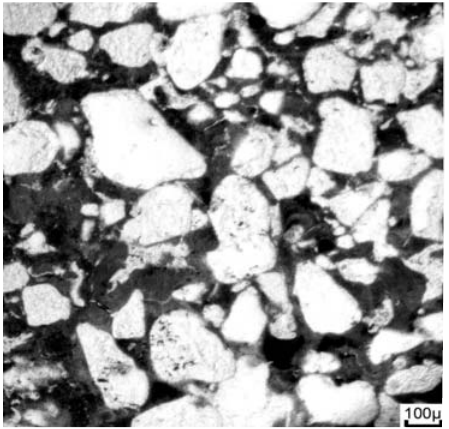
Figura 5. Estrutura de base porfirogrânica com porosidade cavitária e fissuras finas no horizonte BA do perfil